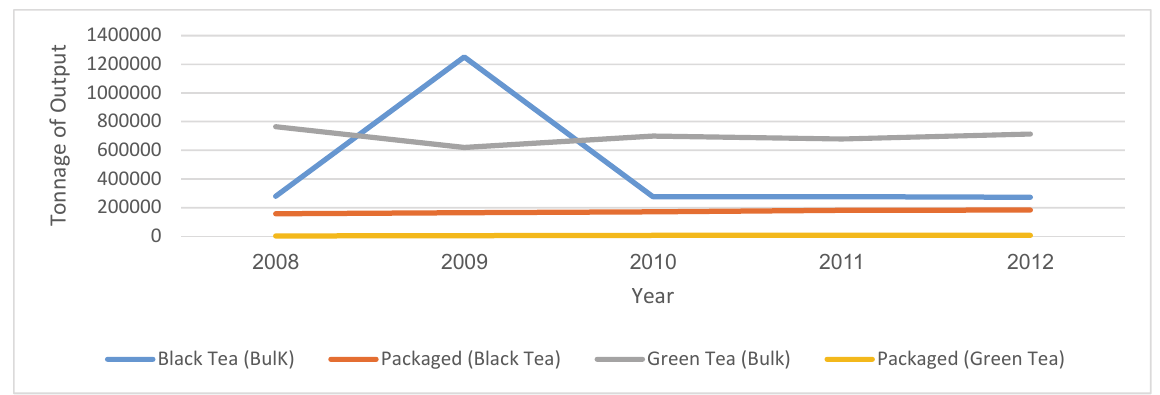
Fig. 2. Tea Production